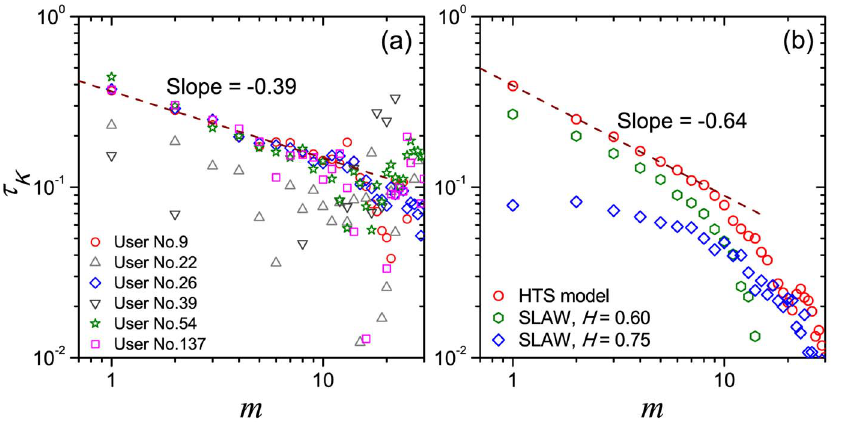
Figure 9. The decay of Kendall’s Tau t K between ~ dd i and ~ dd i z m versus the interval m for several typical users (a) and modeling series (b). The wine dashed line in panel (a) is the fitting curve of user No. 26. The red, green and blue data points in panel (b) are respectively the results of HTS model, and SLAW model with different Hurst exponent H . Each data point in the modeling results is an average of ten runs of simulations.